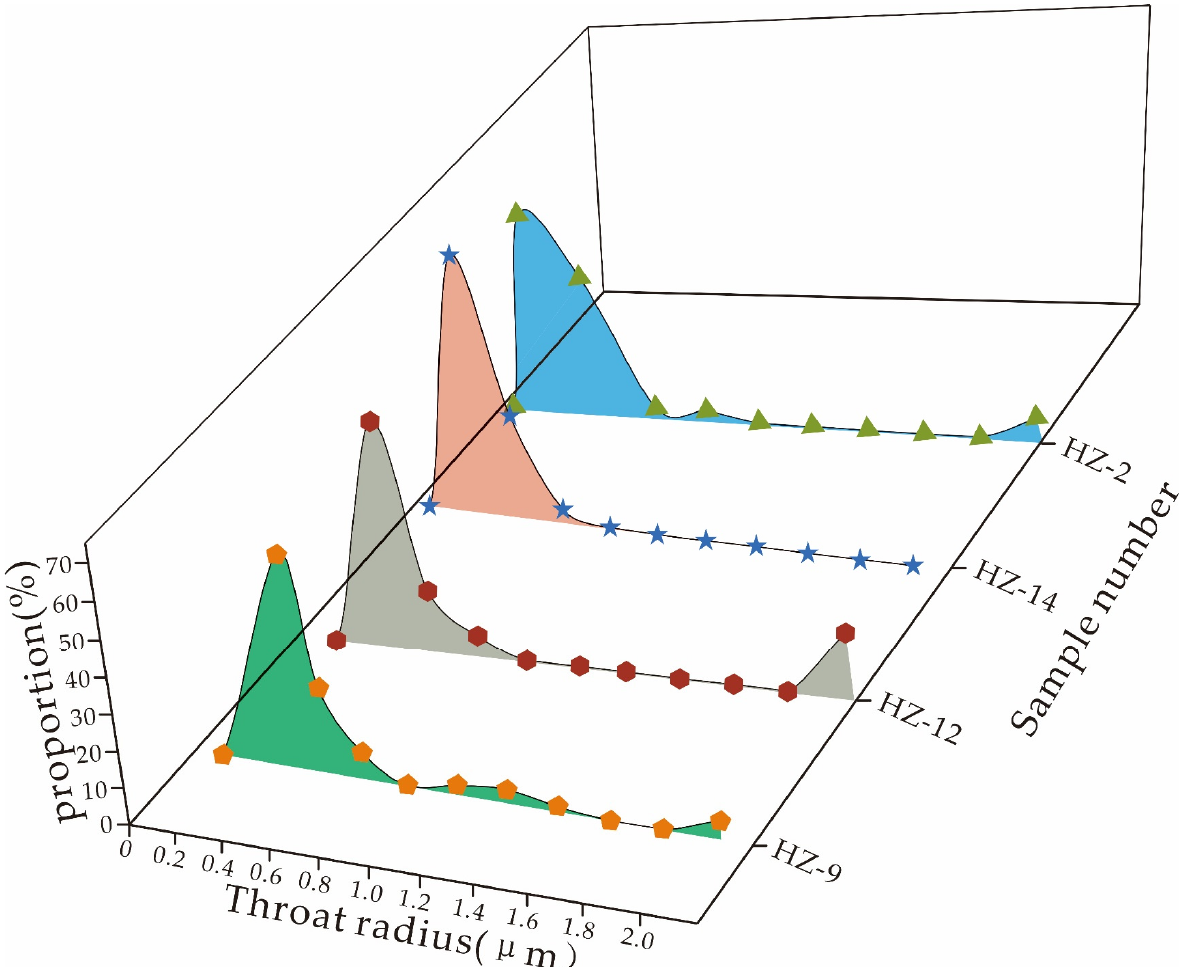
Figure 7. Ratio of the carbonate pore throat radius in the Huize lead–zinc deposit.